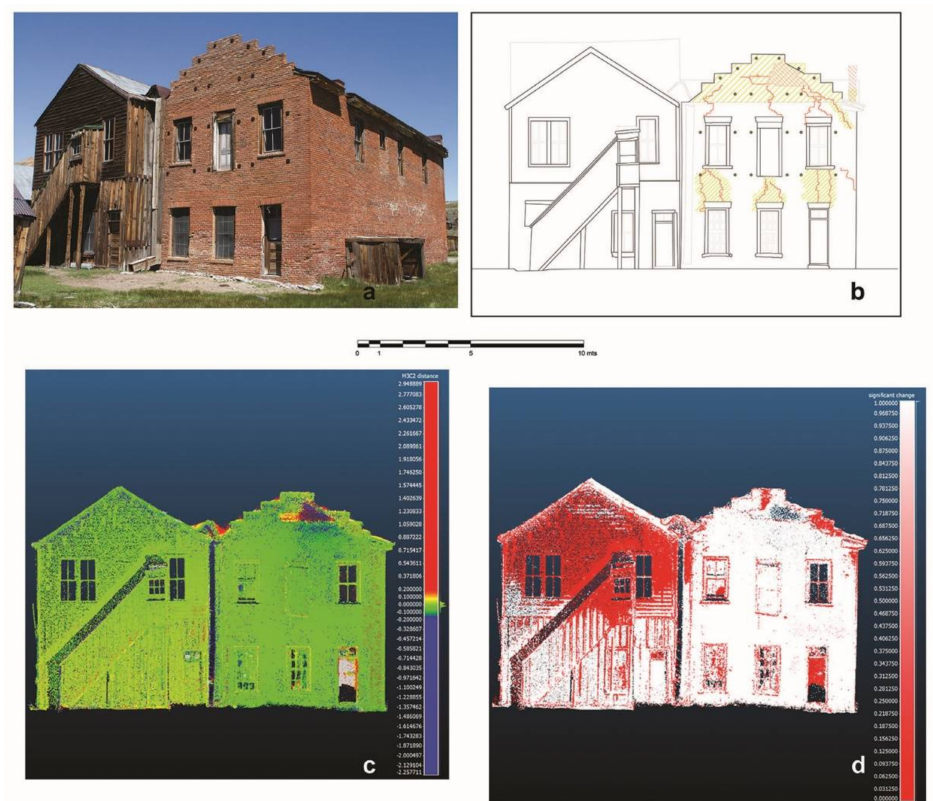
Figure 16. On-scale visualization of ( a ) photograph of the Dechambeau Hotel and IOOF Hall’s West façades; ( b ) damage map showing cracks and collapsed material (red) caused by the 2016 earthquake and the repair and consolidation work (yellow); ( c ) M3C2 distance map visualizing the surface change in centimeter between 2016 pre-disturbance dataset and 2017 post-disturbance dataset; ( d ) M3C2 significant change map highlighting visible and invisible damage patterns. ( a ) By N. Lercari; ( b ) by A. Campiani; ( c , d ) by A. Guillem and C.